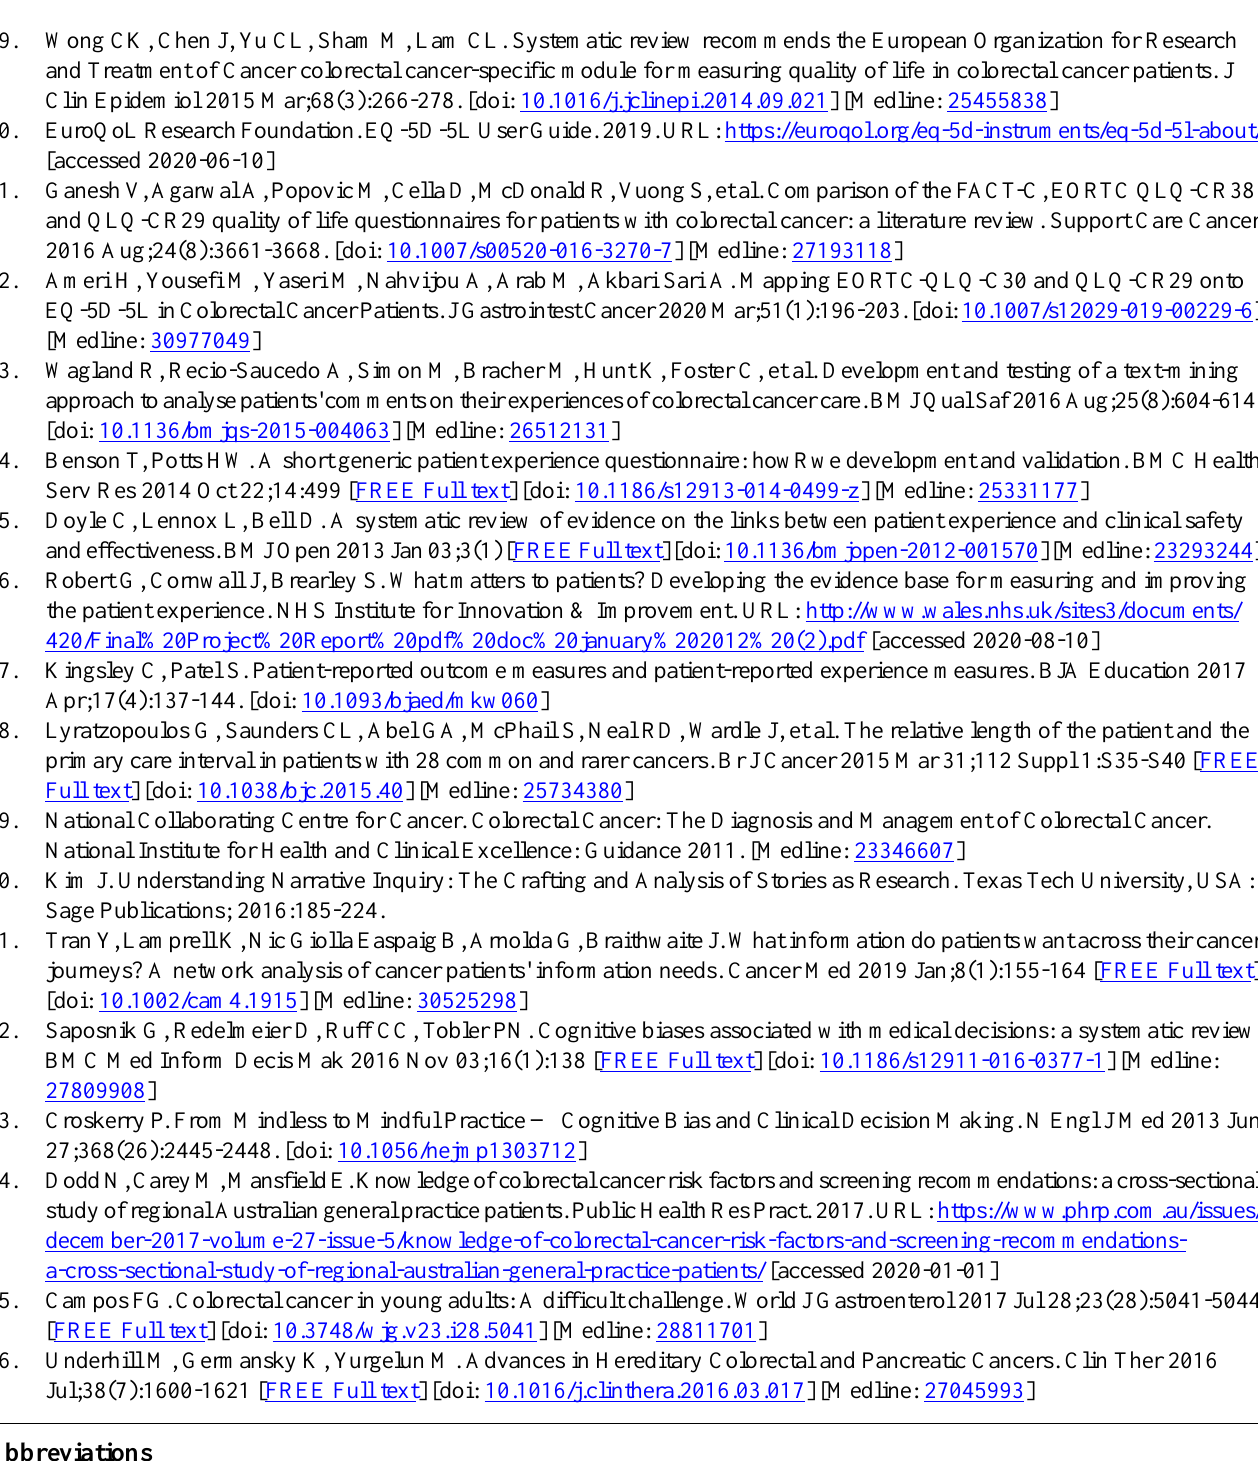
Abbreviations EORTC-QLQ-CR29: European Organization for Research and Treatment of Cancer-Quality of Life Questionnaire-29-item colon and rectum cancer-site specific EQ-5D: European Quality of Life Questionnaire-5 dimension FACT-C: Functional Assessment of Cancer Therapy-Colorectal PRE: patient-reported experience PRO: patient-reported outcome PROD: personal recollections organized as